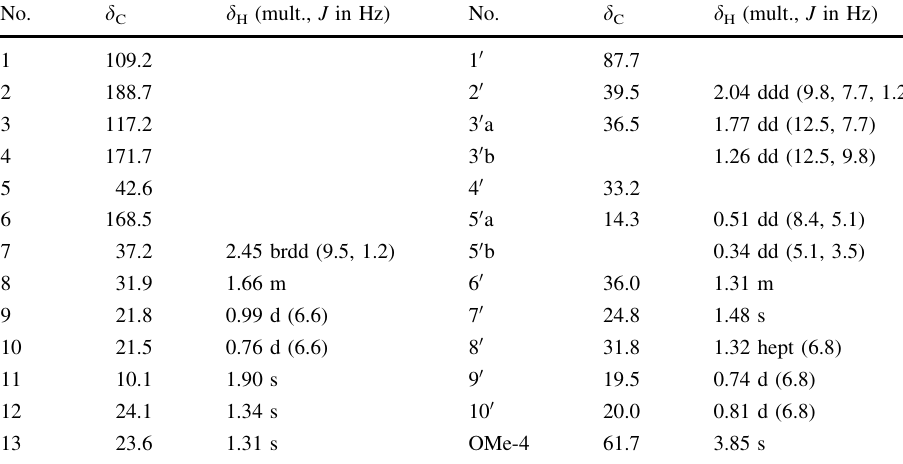
Table 1 1 H (500 MHz) and 13 C (125 MHz) NMR data of 1 in